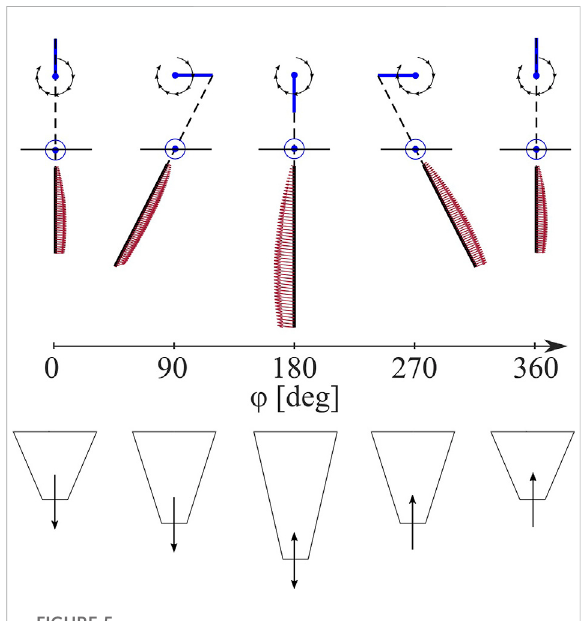
FIGURE 5 Anisotropic Leg Trajectory. Leg spatial position in black lines and force distribution in red arrows (top) and leg extension (bottom) depicted throughout a burrowing sequence from a leg pose of ϕ = 0 – 360 ° relative to full